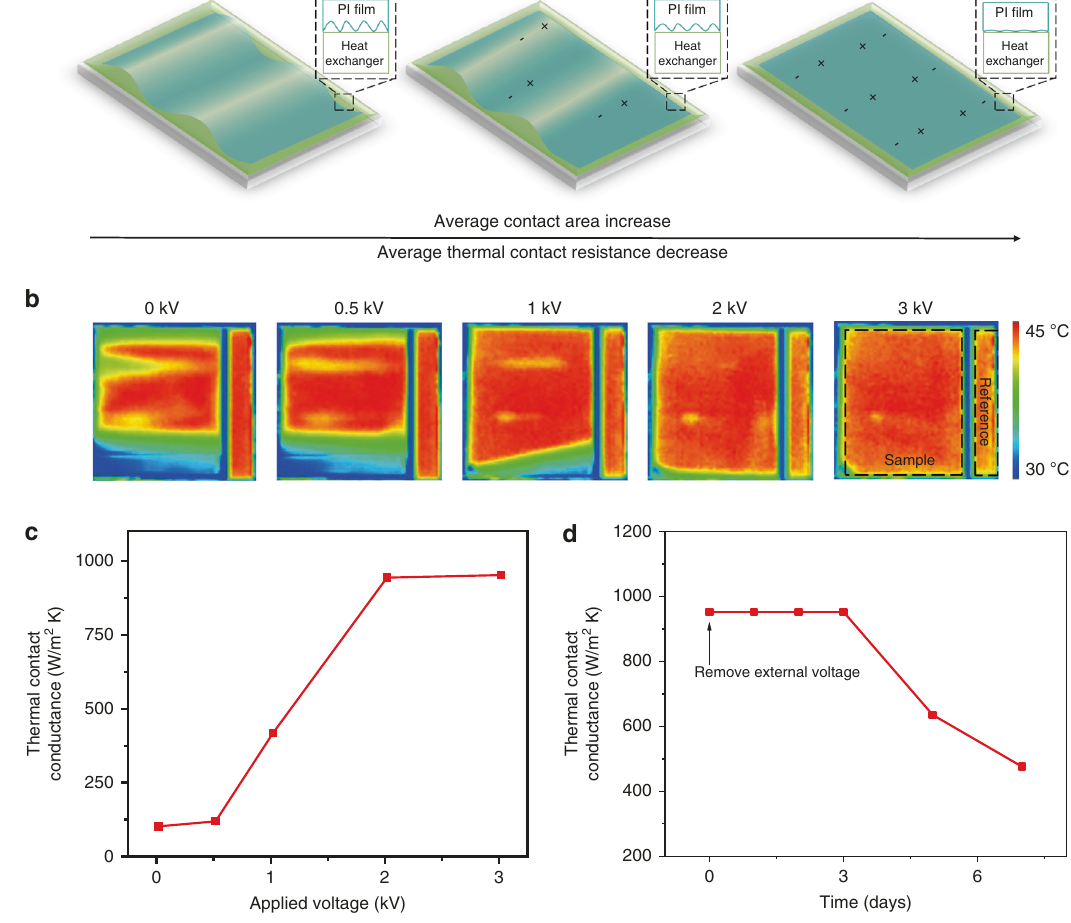
Fig. 2 Reducing the average thermal contact resistance by the electrostatic effect. a Schematic of dual-mode material morphology evolution as the function of surface static charges. As the static charge increases by either triboelectricity or applied voltage, the Maxwell pressure can increase both the macroscopic contact area and the local contact conductance, which signi fi cantly decreases the overall thermal contact resistance. b Thermography images of the cooling material on a constant temperature substrate after applying 0, 0.5, 1, 2, and 3 kV, respectively. c Average thermal conductance over applied voltage. d The average thermal conductance remains unchanged for 3 days even after the applied voltage is removed because of the strong tendency of the PI fi lm to retain surface